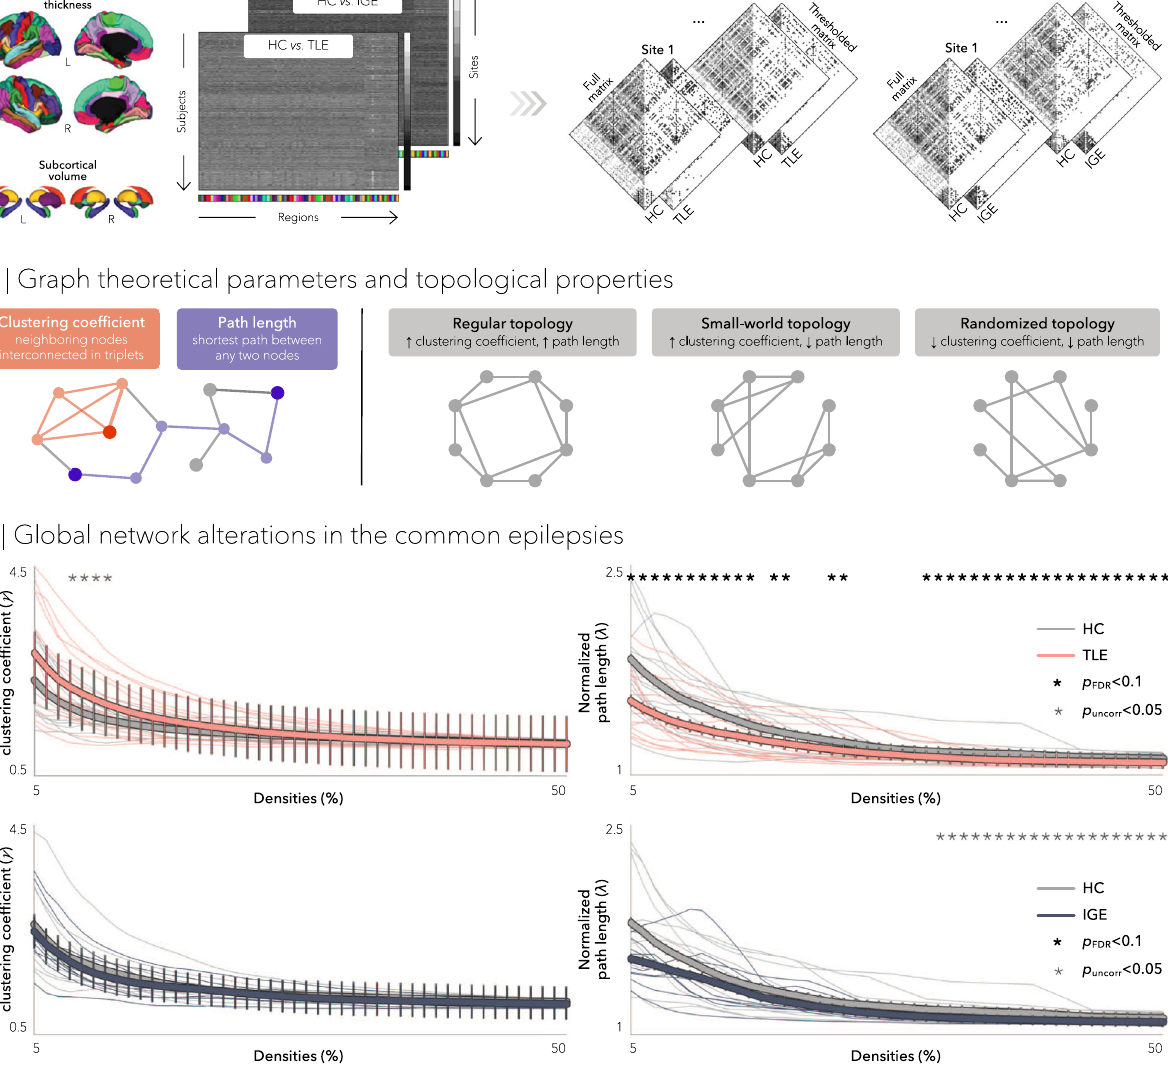
Fig. 1 Structural covariance networks in the common epilepsies. a Schematic showing the construction of group- and site-speci fi c structural covariance networks from morphometric correlations. b Two graph theoretical parameters characterized network topology: clustering coef fi cient, which measures connection density among neighboring nodes ( orange ) and path length, which measures the number of shortest steps between any two given nodes ( purple ). The interplay between clustering coef fi cient and path length can describe three distinct topological organizations: regular networks with high clustering and path length ( left ), small-world networks with high clustering and low path length ( middle ), and random networks with low clustering and path length ( right ). c Global differences in clustering coef fi cient ( left ) and path length ( right ) between TLE and HC ( top ) and between IGE and HC ( bottom ) are plotted as a function of network density. Increased small-worldness ( i.e ., increased clustering and decreased path length) was observed in individuals with TLE, whereas individuals with IGE showed decreases in clustering and path length, suggesting a more random con fi guration. Two-tailed student ’ s t -tests were performed at each density value, comparing global measures in patients (TLE or IGE) to controls; bold asterisks indicate p FDR < 0.1, semi-transparent asterisks indicate p uncorr < 0.05. Thin lines represent data from individual sites. Error bars indicate standard error of the mean. HC = healthy control, IGE = idiopathic generalized epilepsy, TLE = temporal lobe epilepsy, p FDR = p -value adjusted for false discovery rate, p uncorr = uncorrected p To further assess speci fi city to hippocampal sclerosis (in TLE) sets of genes associated with common neuropsychiatric condi- and generalized epilepsy (in IGE) genes, we cross-referenced our tions and/or comorbidities of epilepsy, including: attention network fi ndings with transcriptomic maps derived from (i) genes de fi cit/hyperactivity disorder 47 , autism spectrum disorder 48 , bipolar disorder 49 , major depressive disorder 50 , migraine 51 , and associated to four additional epilepsy phenotypes, namely: all schizophrenia 52 (Supplementary Table 2). Network alterations in epilepsy, focal epilepsy, juvenile myoclonic epilepsy, and child- TLE did not correlate to any other epilepsy subtype (range hood absence epilepsy 33 , (ii) a set of monogenic epilepsy genes from the Epi4K Consortium 45 and the GeneDX comprehensive r = – 0.15 – 0.13, all p spin/rand > 0.11/0.16; Fig. 4). In contrast, IGE epilepsy panel (http://www.genedx.com), (iii) genes that are showed additional signi fi cant associations with transcriptomic targets of currently used anti-seizure medications 46 , and (iv) six maps derived from all epilepsy ( r = 0.37, p spin/rand = 0.0019/